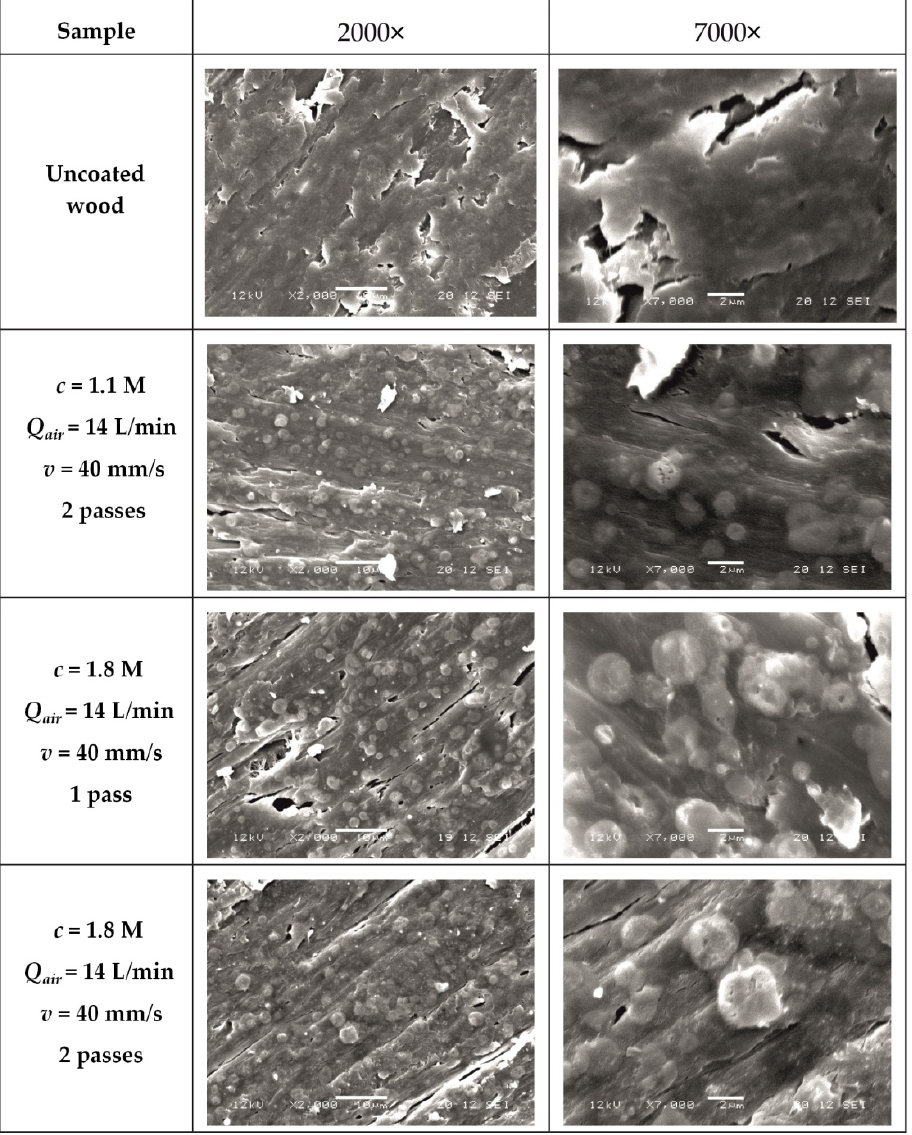
Figure 1. Scanning electron microscope (SEM) images with a magnification of 2000× (scale bar 10 μ m) and with a magnification of 7000× (scale bar 2 μ m) of uncoated and coated wood surfaces.